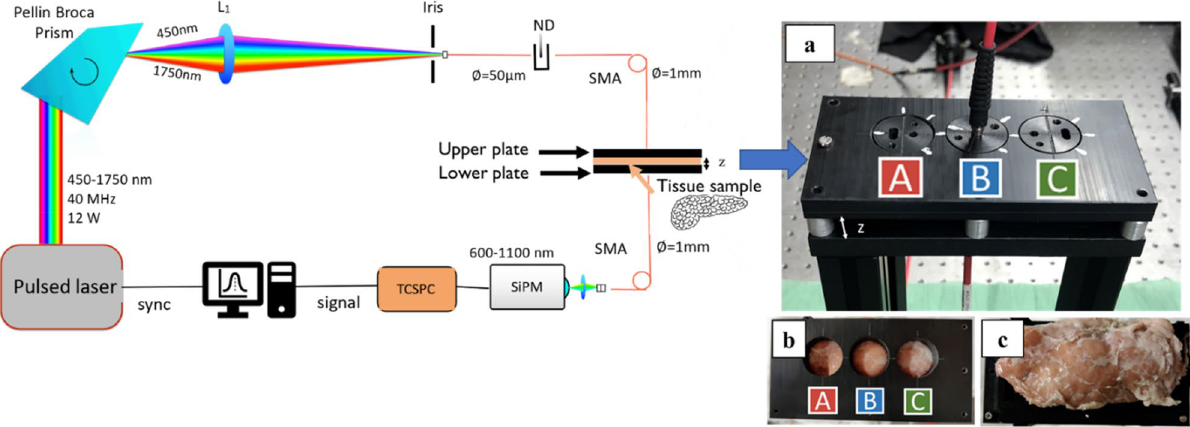
Figure 5. (Left) Schematic of the broadband diffuse optical spectrometer used to measure the ex vivo porcine pancreas optical properties. A pulsed broadband supercontinuum laser beam is spectrally dispersed by a Pellin Broca prism and cleaned by an iris before it enters the injection/source fiber. Temporal (ps) distribution of dispersed photons transmitted through the sample is detected by a Silicon Photomultiplier (SiPM) detector and resolved by a Time Correlated Single Photon Counting (TCSPC) board. (Right). ( a ) Image of PVC plates used to hold the source and the detection fibers and between which the sample is gently locked. A, B, and C indicate the three spatially separated locations chosen for the measurements; ( b ) top view of the upper plate before the injection of the source fiber; ( c ) image of one of the fresh porcine pancreatic samples positioned on the lower plate, which is used to hold the detection